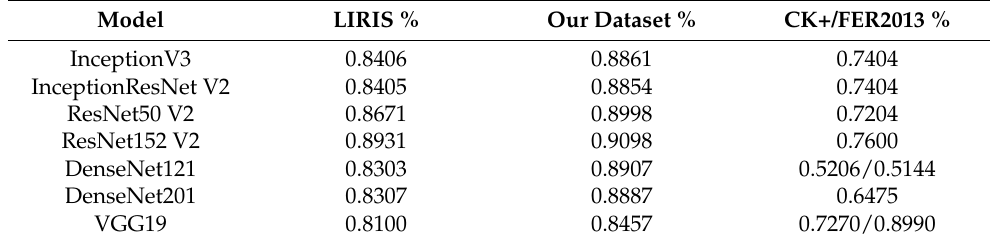
Table 3. Comparison of LIRIS and authors’ dataset accuracy against standard FER benchmark.